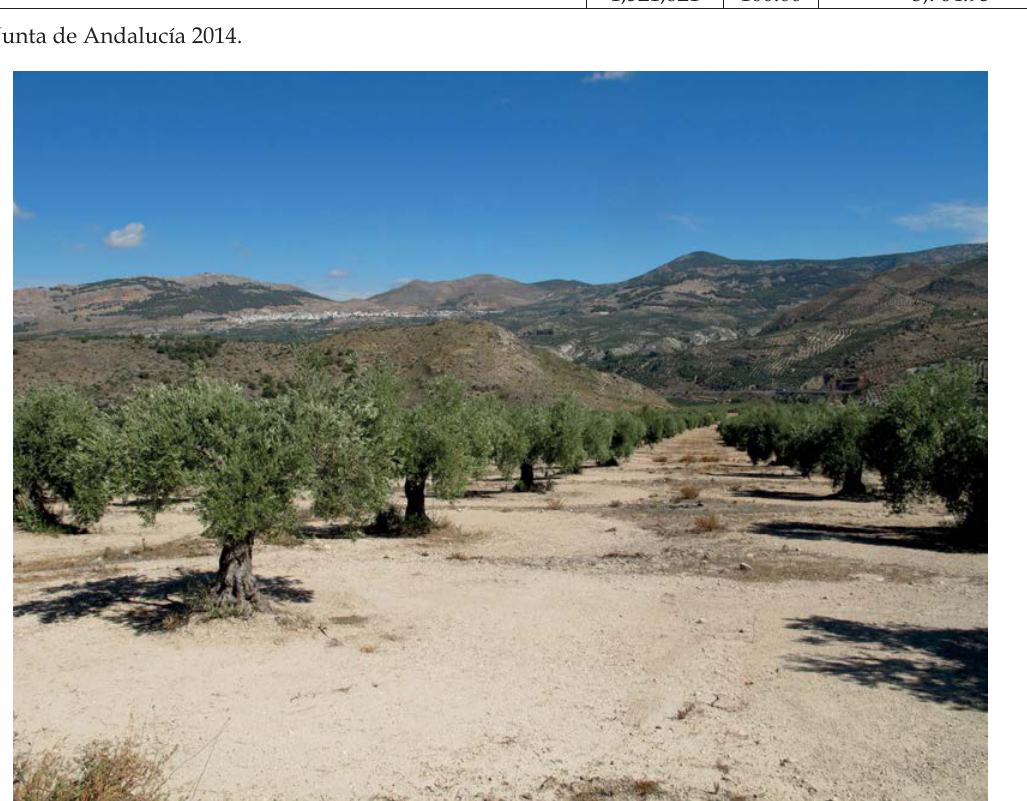
Table 5. Distribution of Andalusian olive groves by yield (the 2009–2010 season). Type Area (ha) % Yield (kg olives/ha) Olive groves with low yields 95,923 6.30 431.25 Olive groves with steep slopes 354,515 3,355.73 Olive groves – extensive with fewer than 150 trees/ha 723,018 Olive groves – extensive with medium density 113,629 Olive groves – intensive Olive groves – super-intensive